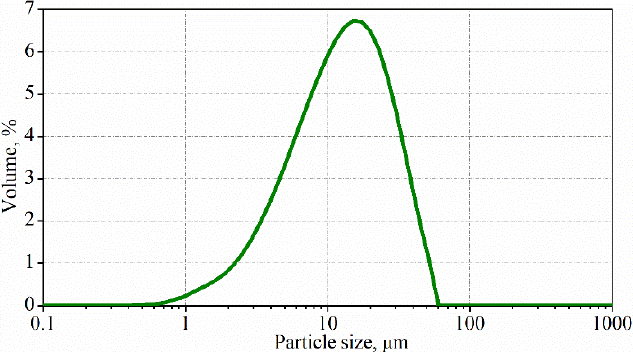
Figure 3. Particle size distribution after exfoliation of expanded graphite.